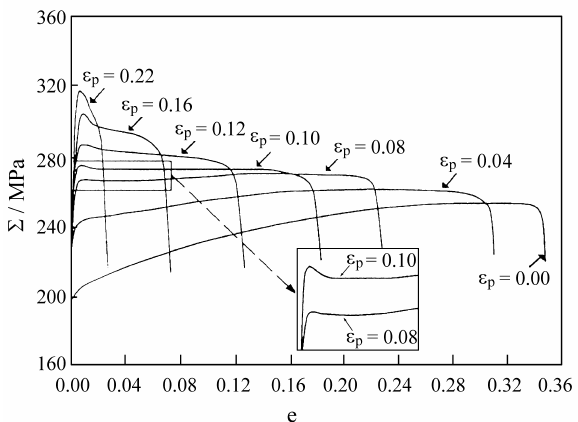
Figure 2. Examples of nominal stress ( Σ ) - nominal strain (e) curves in tension of samples prestrained in rolling. The curve without prestrain ( ε p = 0) is also shown.